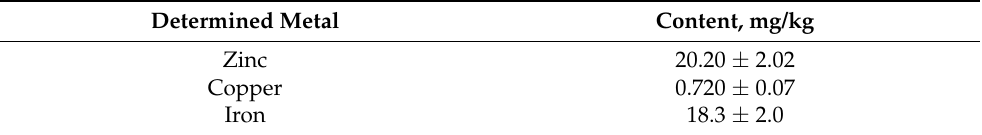
Table 2. Residual content of zinc, copper, and iron in biomass samples.